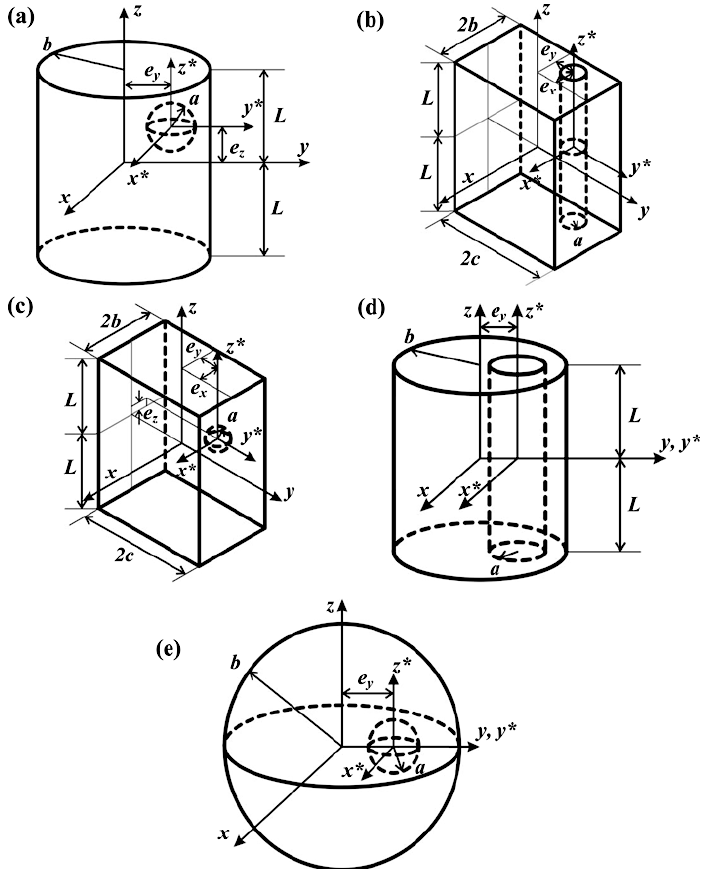
Fig. 1. Problem geometries. (a) fi nite cylinder with an internal spherical cavity. (b) solid parallelepiped with an internal cylindrical cavity. (c) solid parallelepiped with an internal spherical cavity. (d) fi nite cylinder with an internal cylindrical cavity. (e) solid sphere with an internal spherical